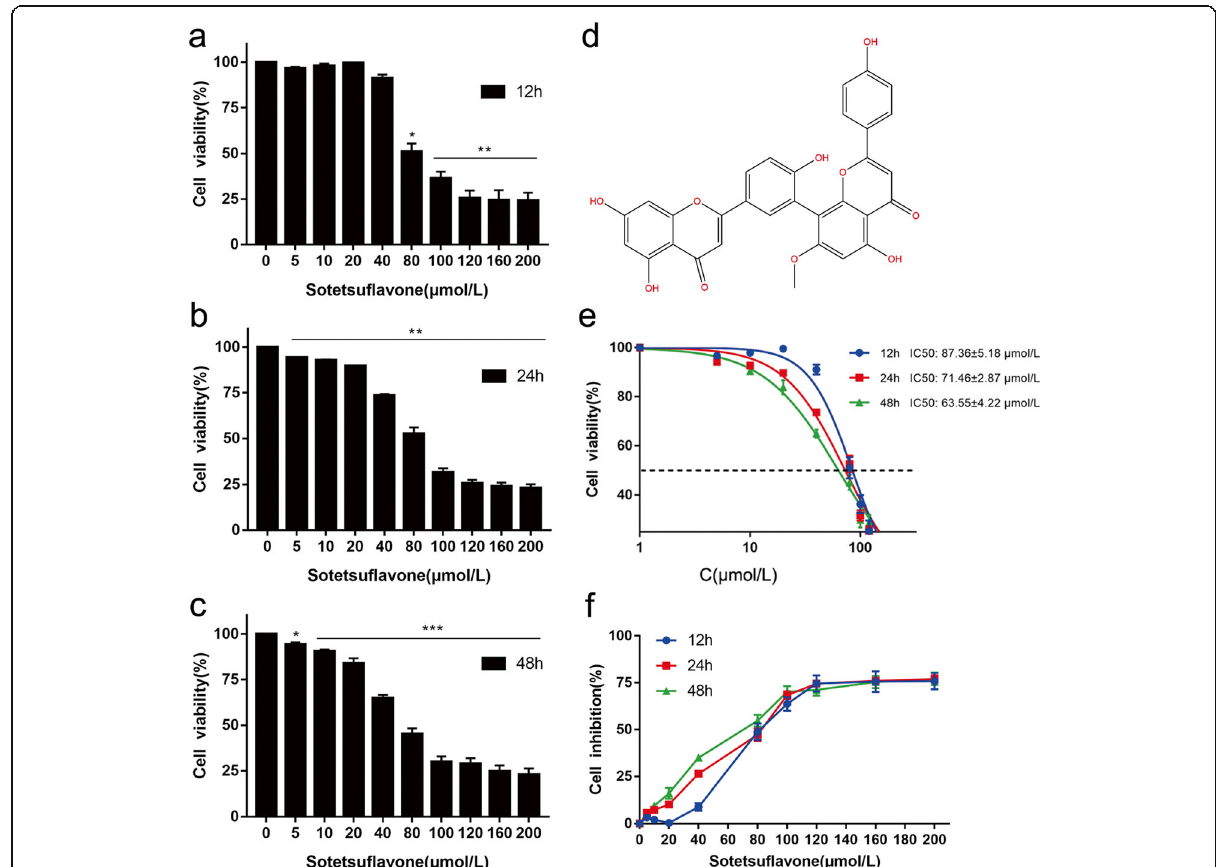
Fig. 1 Effects of sotetsuflavone on A549 cells survival. a , b , c show changes of cell viability of A549 cells treated with different concentrations of sotetsuflavone for 12 h, 24 h and 48 h respectively. The viability of A549 cells were significantly different after 12 h, 24 h and 48 h compared with that of control groups ( P < 0.05, ** P < 0.01, *** P < 0.001). d Molecular structure of sotetsuflavone. e The cytotoxicity of sotetsuflavone in A549 cells, there was no significant difference in IC50 values between 24 h and 48 h after drug treatment ( P >0.05). f The inhibition rate of sotetsuflavone at 12, 24 and 48 h. When the drug concentration was more than 80 μ mol/L, the inhibitory effect of the three times gradients was not different ( P >0.05). Combined with Fig. 1a, b, c, e, f, the final selection of 24 h as the follow-up experimental treatment time, and the subsequent experimental concentration adjusted to 0, 64, 128 μ mol/L. The results from three independent experiments were expressed as mean±SD compared with the control group, * P <0.01, ** P <0.01, *** P